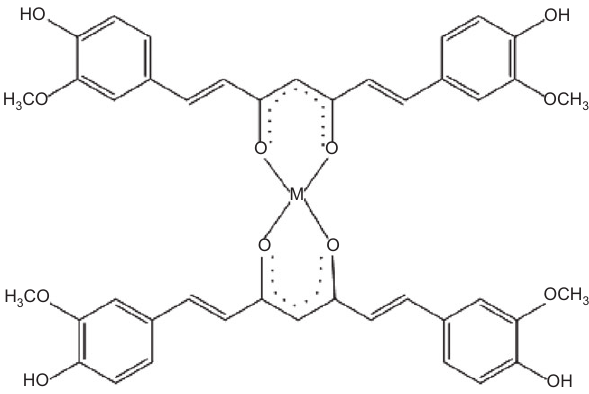
Figure 1 Structure of the metal complexes of curcumin. M = Cd(II), Hg(II), Pb(II), Sn(II) and